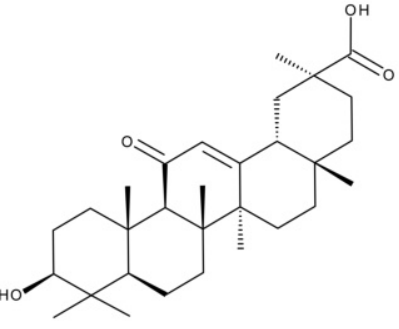
Figure 20. Chemical structure of glycyrrhetinic